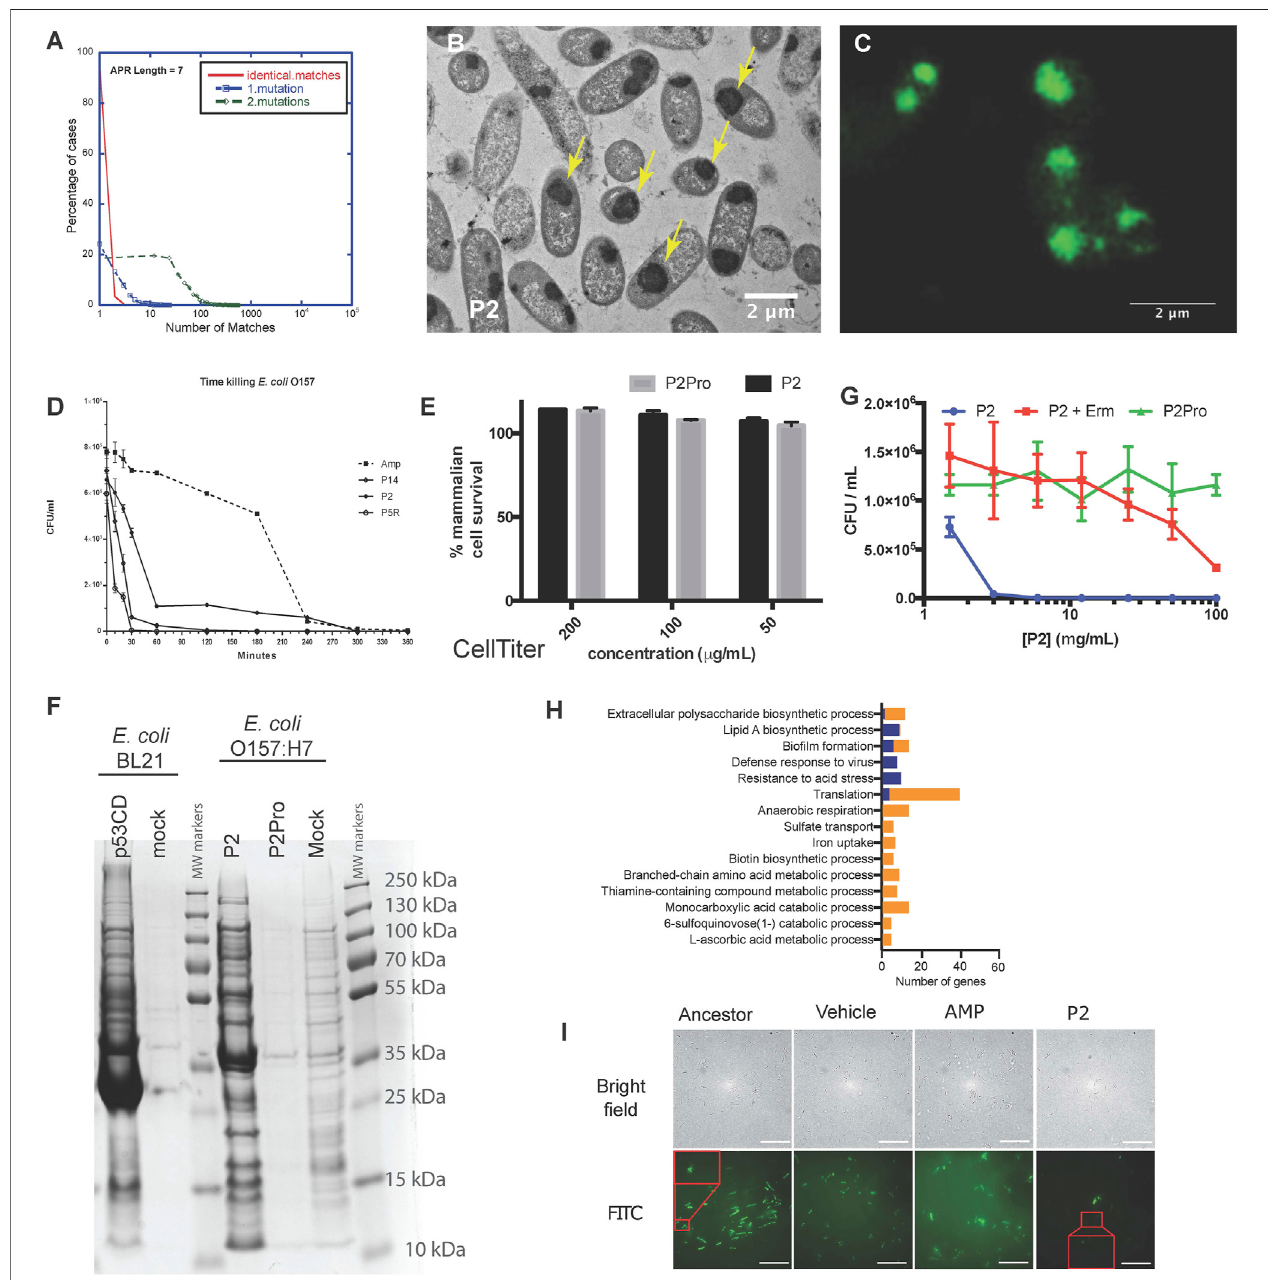
FIGURE3|(A) AsmallfractionofAPRsareredundant:mostAPRsofsevenaminoacidsoccurinnomorethan fi veproteinsinthe E.coli proteome(redcurve).The number of homologous APRs in the proteome increases if we allow one mismatch (blue curve) or two mismatches (green). (B) Transmission electron microscopy of cross-sections of resin-embedded E. coli O157:H7 treated with P2 peptide at MIC concentration for 2 h. The yellow arrows indicate inclusion bodies. (C) Wide- fi eld structured illumination microscopy image of E. coli O157:H7 treated with peptide P2 and stained with the amyloid-speci fi c dye pFTAA (0.5 µM). (D) Time-killing curve of selected peptides (P14, P2, and P5R) and ampicillin (Amp, dashed line) against E. coli strain O157:H7 treated at MIC concentration (average ± SD of three replicates). (E) NeitherP2(blackbars)noritscontrolvariantcontainingtwoprolinesubstitutions(P2Pro,grey)istoxictohumanHeLacellsasmeasuredusingtheCellTiter Blue assay. (F) Coomassie blue-stained SDS-PAGE of inclusion bodies from E. coli BL21-overexpressing the C-terminal domain of human p53 (p53CD, lane 1), mock- transformed (lane 2), and E. coli O157:H7 treated with P2 (lane 4), P2Pro (lane 5), or DMSO (lane 6). Molecular weight markers are shown in lanes 3 and 7. (G) Growth inhibition of cells treated with P2 with/without erythromycin (Erm, 100 μ g/ml, average ± SD of three replicates). ( A – G Adapted from Khodaparast et al., 2018). (H) The number of genes in different gene ontologies expressed differentially in P2-resistant strains compared with ancestors. Blue indicates upregulation, orange indicates downregulation. Apart fromthe geneontologies Resistance toacidstress andL-ascorbicacid metabolic process, all other groupshad aBonferronistepdown p value < 0.05. (I) Bright fi eld (upper row) and wide- fi eld structured illumination microscopy (lower row) images of bacteria treated with FITC-labelled P2 peptides for 2 h at 12.5 mg/ml. The Pept-in resistant bacteria (P2) contains much less FITC-P2. Scale bar: 10 µm. ( H,I Adapted from Wu et al., 2020).